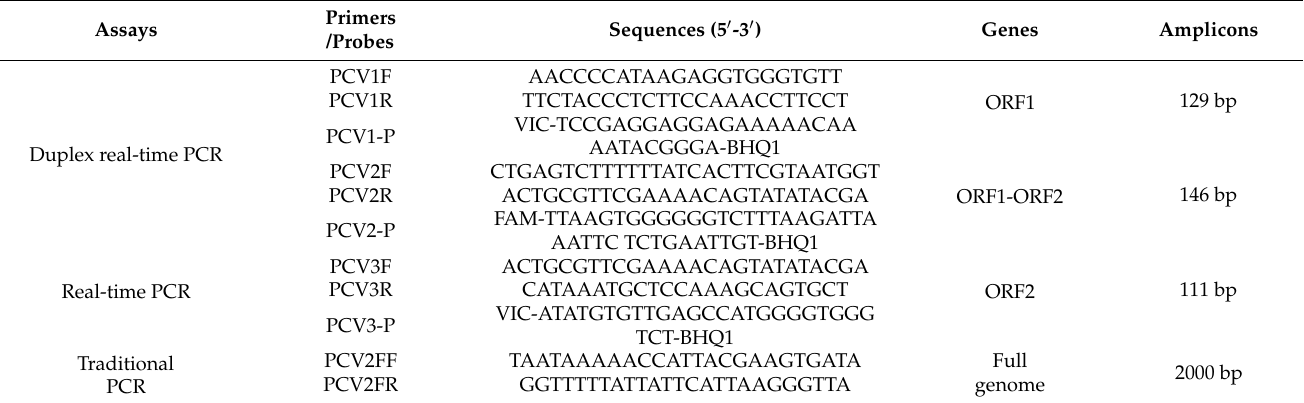
Table 2. Primers and probes the TaqMan detection assay used in this study.